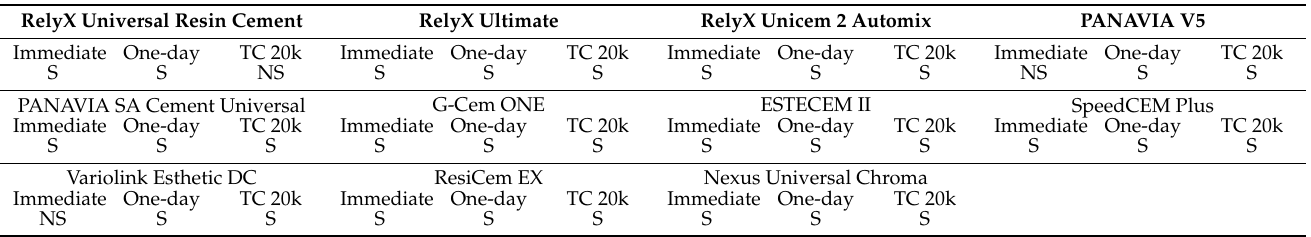
Table 14. Comparison of the results (by t -test) for flexural modulus of each adhesive resin cement material with regard to two curing